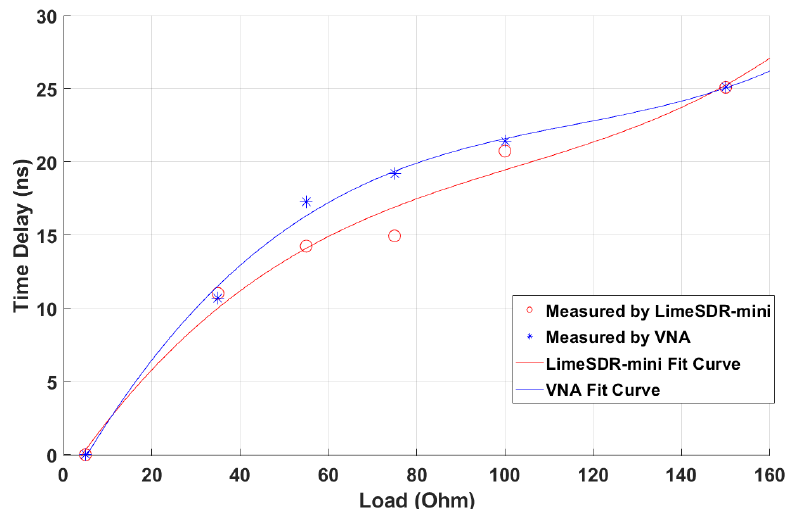
Figure 16. The normalized time delay results for LimeSDR-mini with the absolute time delay scaled based on the VNA and their 3rd fit curve.